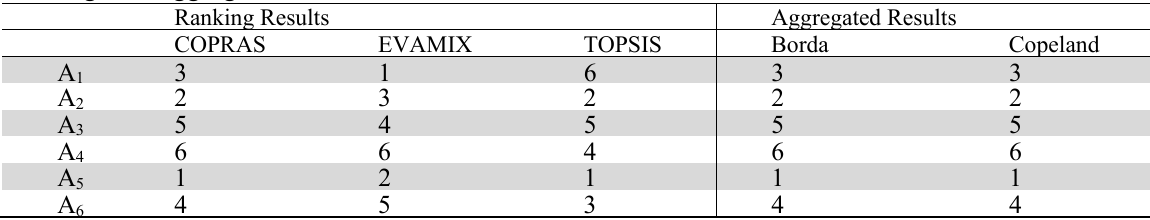
Ranking and Aggregated